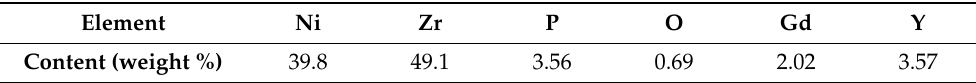
Table 3. Chemical composition of the Ni–P–ZrO 2 composite